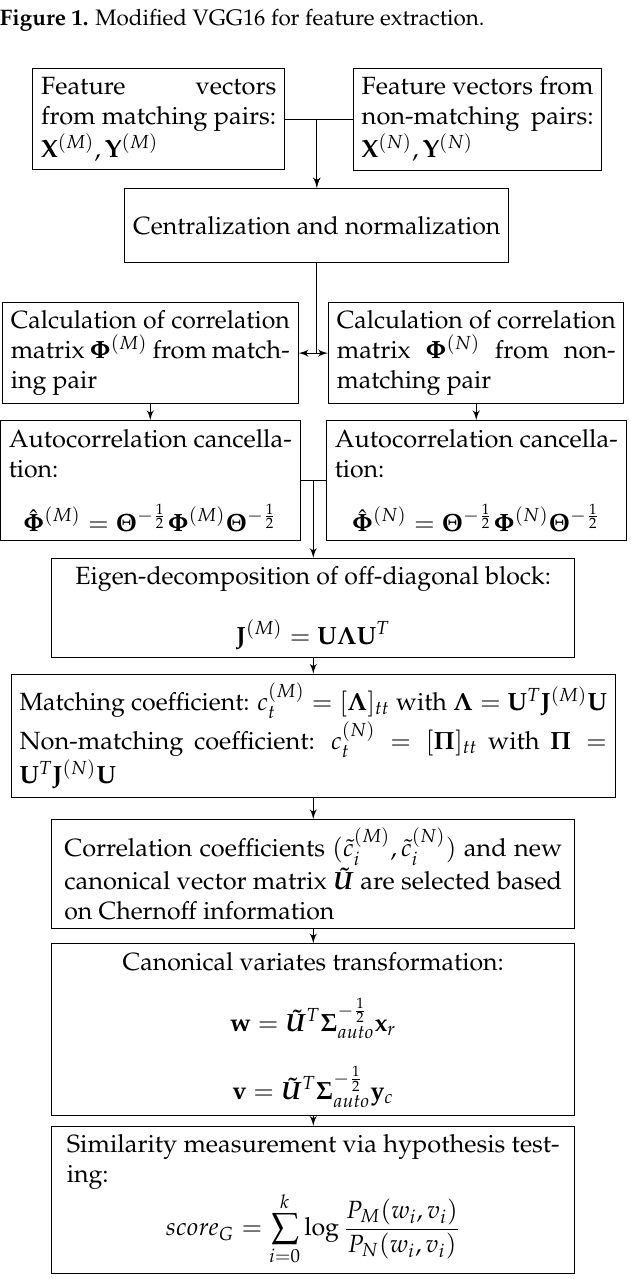
Figure 2. Block diagram of the proposed